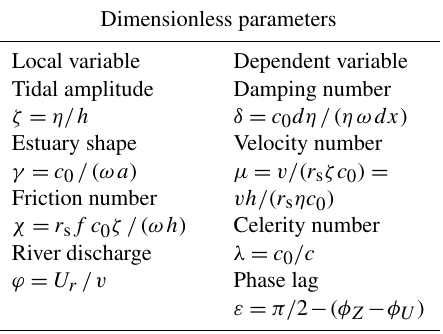
Table 1. Definition of dimensionless parameters (Cai et al.,